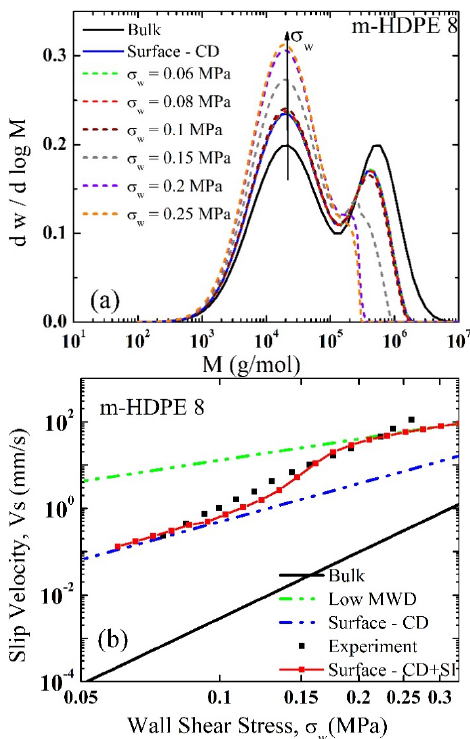
Figure 4. ( a ) The MWDs of bulk (solid line), surface-CD (concentration driven migration given by Equation (6) with only the first term), and the combined surface and shear-driven migration at various wall shear stress values (Equation (6)); ( b ) the slip velocity of m-HDPE-8; the experimental results (black squares), the bulk and low MWD are calculated based on Equation (5) with no migration effects, the concentration driven migration (surface CD) (Equation (6) only the first term) and the combined concentration and shear-driven migration (CD+SI) slip velocity (red squares connected with a continuous line) using Equation (5) coupled with Equation